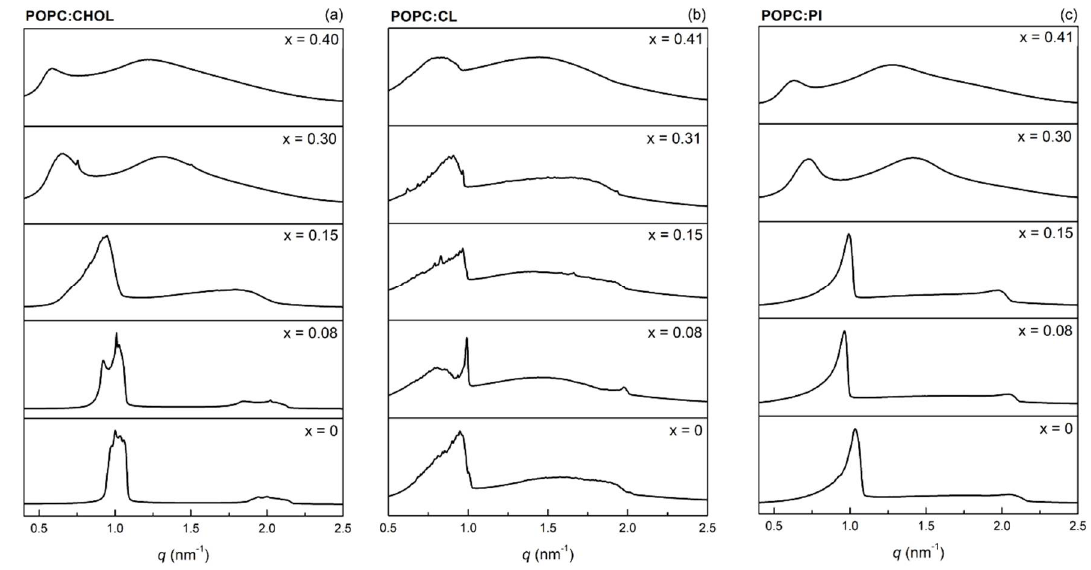
Figure 5. Average SAXS profiles of ( a ) POPC:CHOL (80:20), ( b ) POPC:CL (85:15), and ( c ) POPC:PI (85:15) bilayers at 37 °C and pH 7.4 as a function of NAP:lipid molar ratio (x).